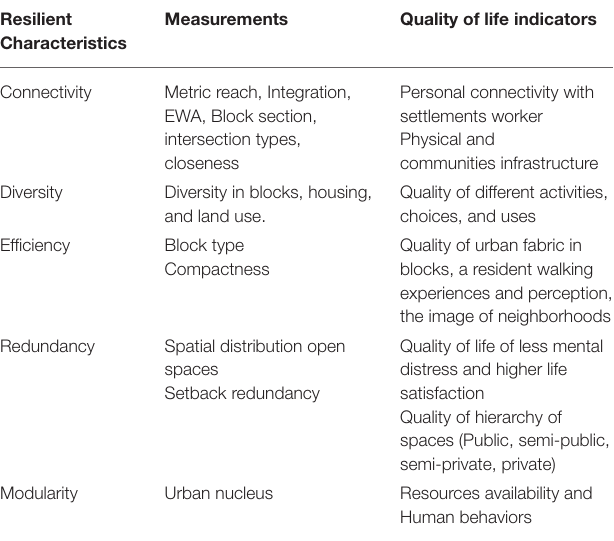
TABLE 6 | Adapted the matrix of the sustainability of urban forms by Jabareen